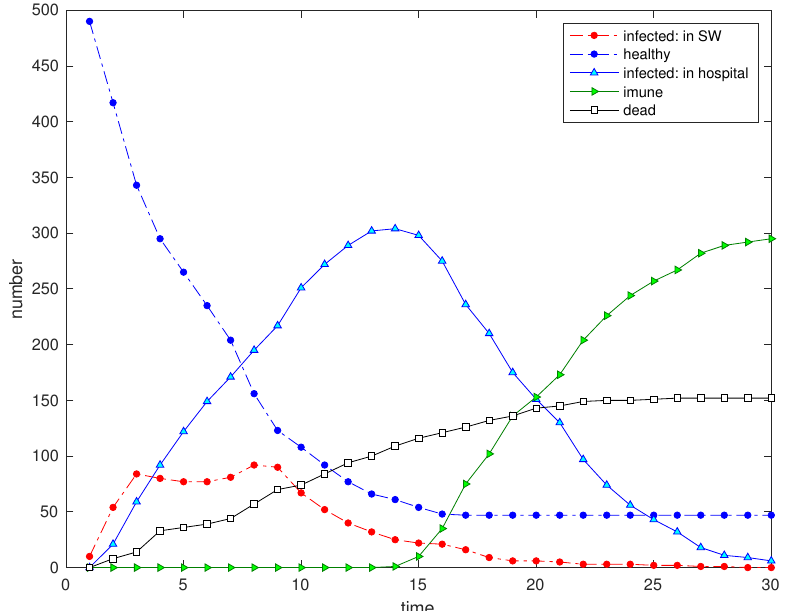
Figure 17. Scenario S 10 : Time evolution of the 5 state variables for n i = 10 ( N = 500, D = 0.07, δ = 0.1, p 1 = 0.1, p 2 = 0.9, p 3 = 0.7, α = 2 and N h → ∞ ).